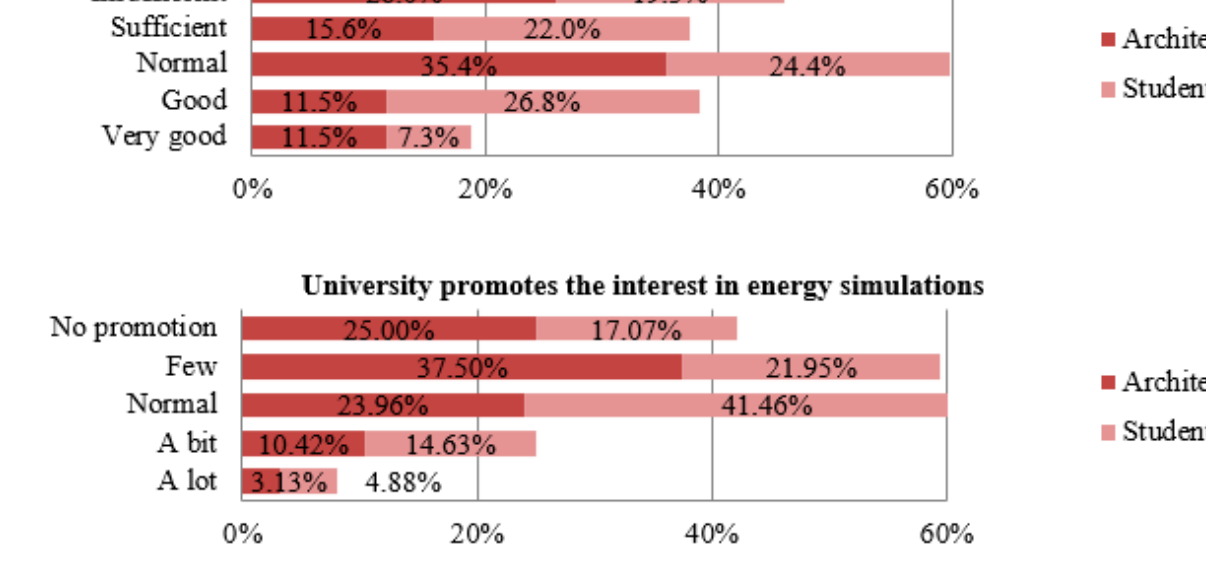
Figure 5. Tools used during the design stage and users’ skills.